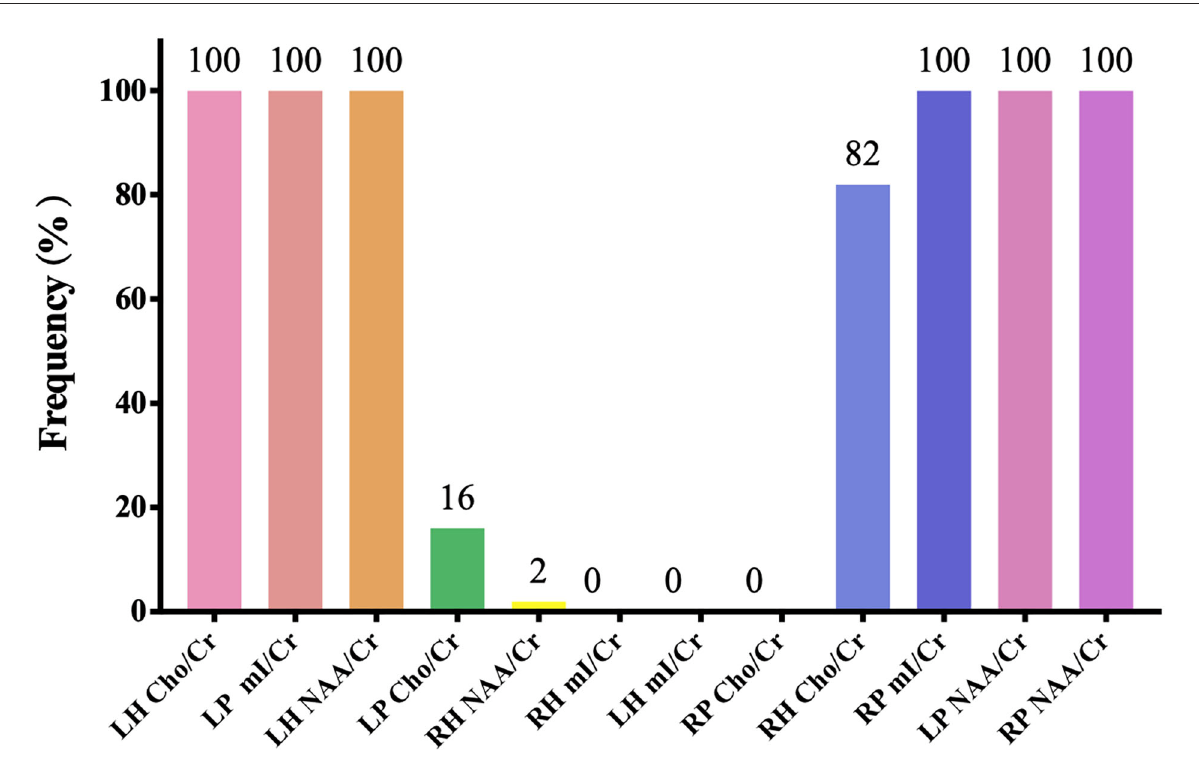
FIGURE4 The frequency of each feature corresponding to the highest classification accuracy (LH, left hippocampus; RH, right hippocampus; LP, left prefrontal whiter matter; RP, right prefrontal whiter matter; NAA, N-acetylaspartate; Cho, choline; mI, myo-inositol; Cr,